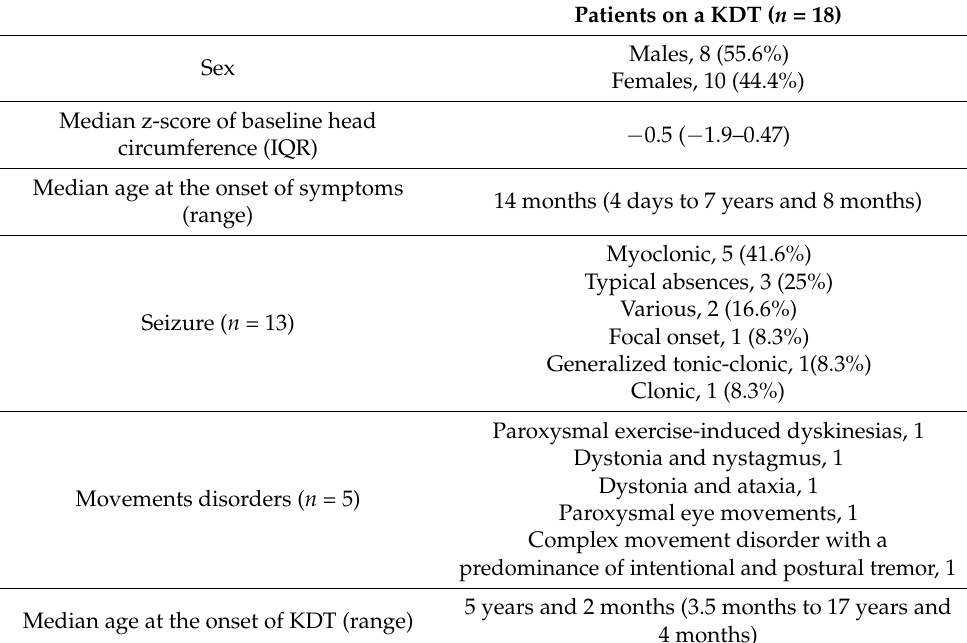
Table 1. Demographic and clinical characteristics of the patients and the ketogenic dietary therapies (KDT) in the